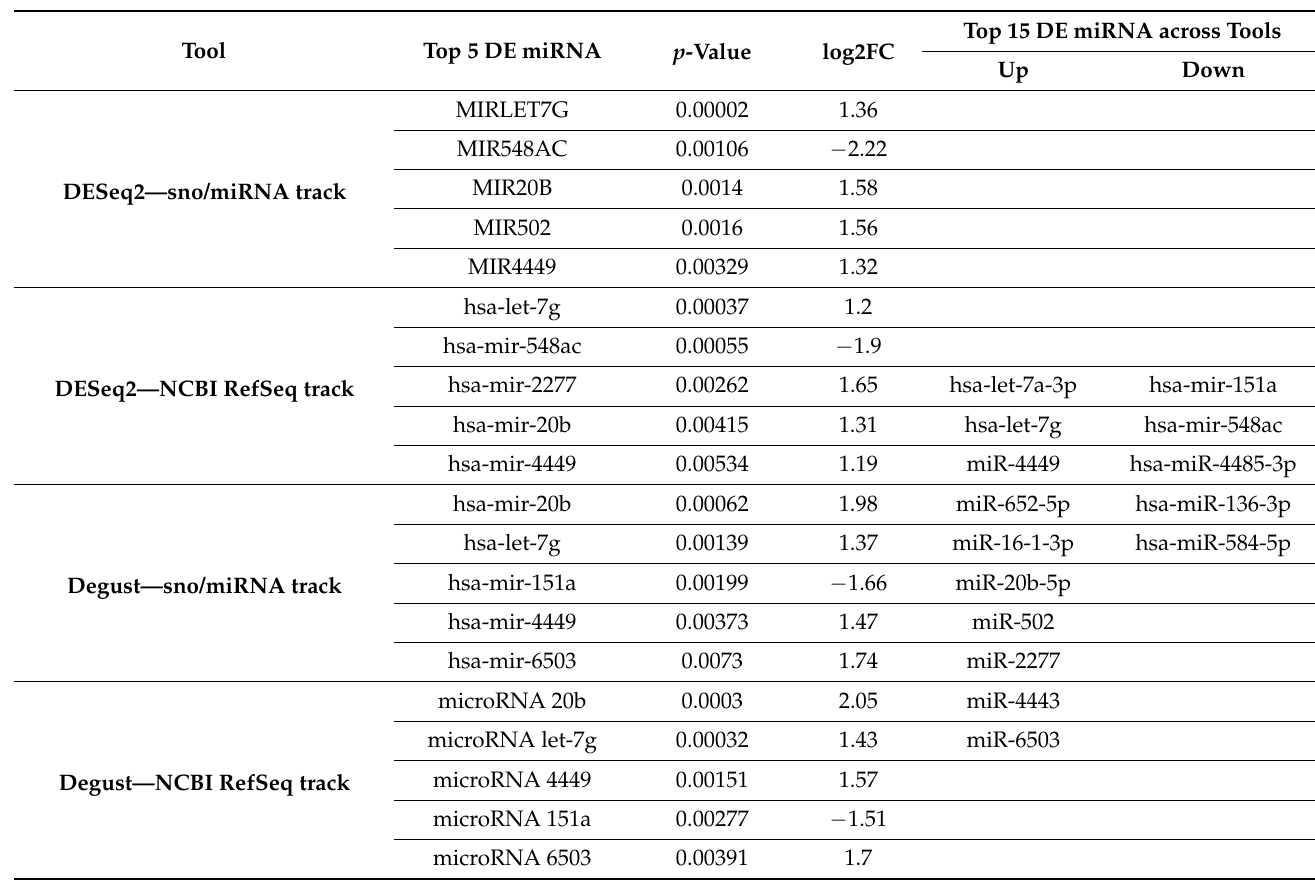
Figure 2. Representative heatmap portraying the top 10 significantly dysregulated miRNAs based on the DESeq 2 (sno/miRNA track) analysis. A clear difference is seen between the AD and control groups. Table 1. Differentially expressed (DE) miRNA found in peripheral NMV from AD subjects based on analysis conducted across different tools.